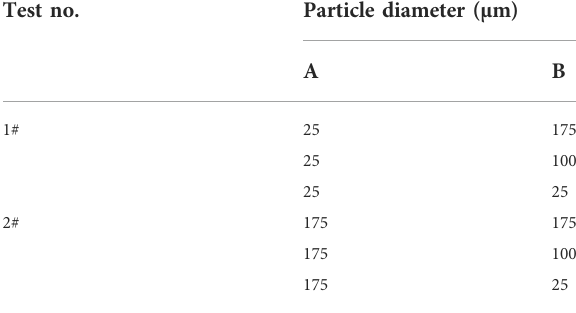
TABLE 5 The particle diameter combination of double-layer plates. Test no.